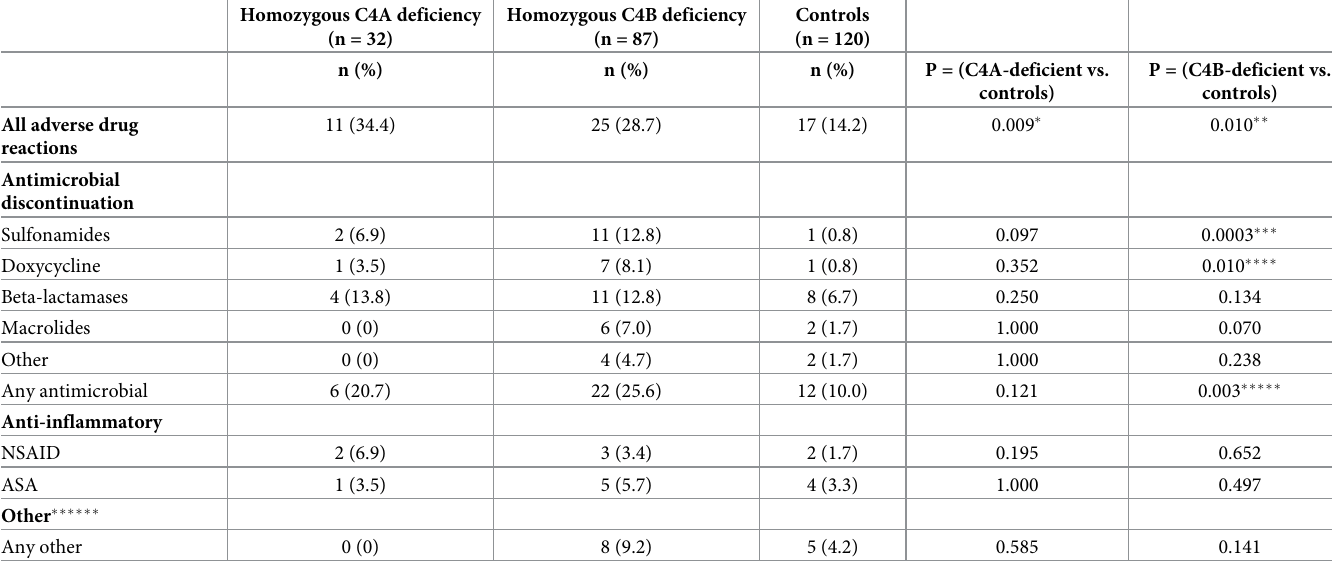
Table 4. Adverse drug reactions with homozygous C4